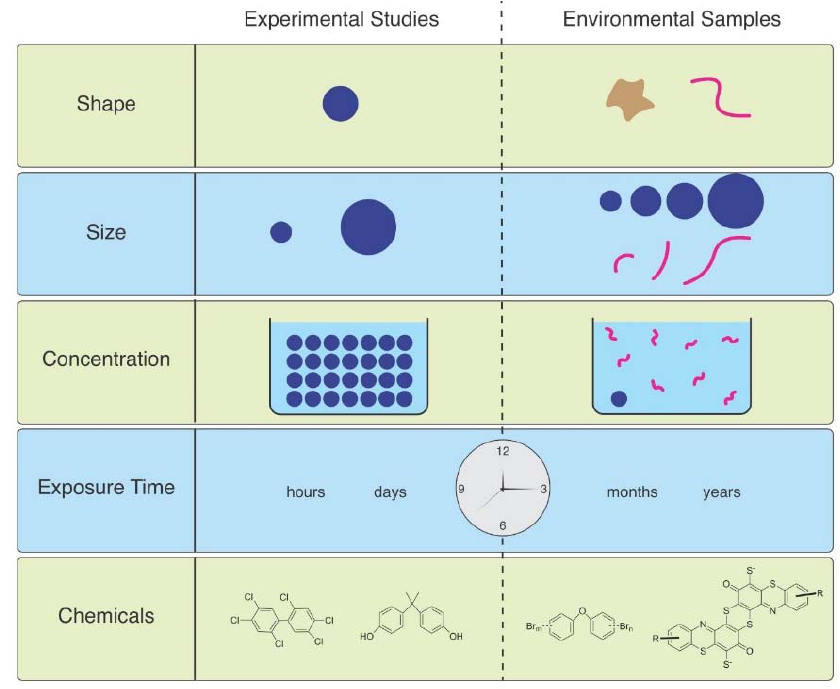
Figure 1. The mismatch between MPs used in laboratory studies and those in the environment. Microfiber (MF) uptake by Asian clams ( Corbicula fluminea ) varied by polymer type and size. The uptake of fibers was greater in those exposed to greater concentrations than lower concentrations, and clams were more likely to take up polyester fibers of smaller size [7]. Horn et al. (2019) used polypropylene rope as a source of microfibers, the